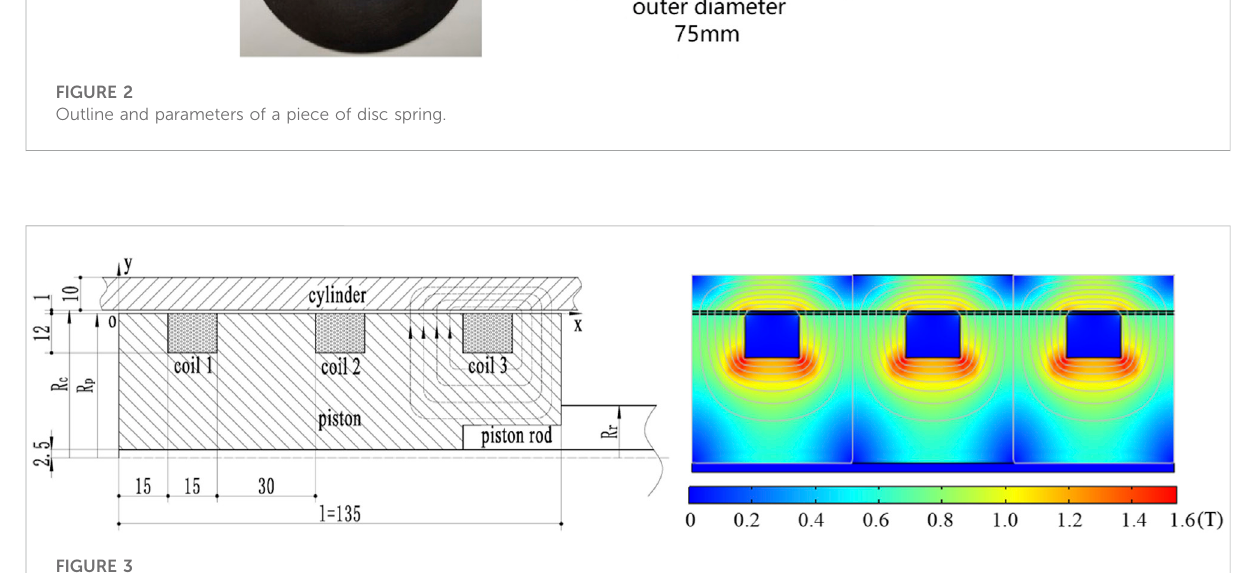
FIGURE 3 Schematic and magnetic distribution of the magnetorheological valve in